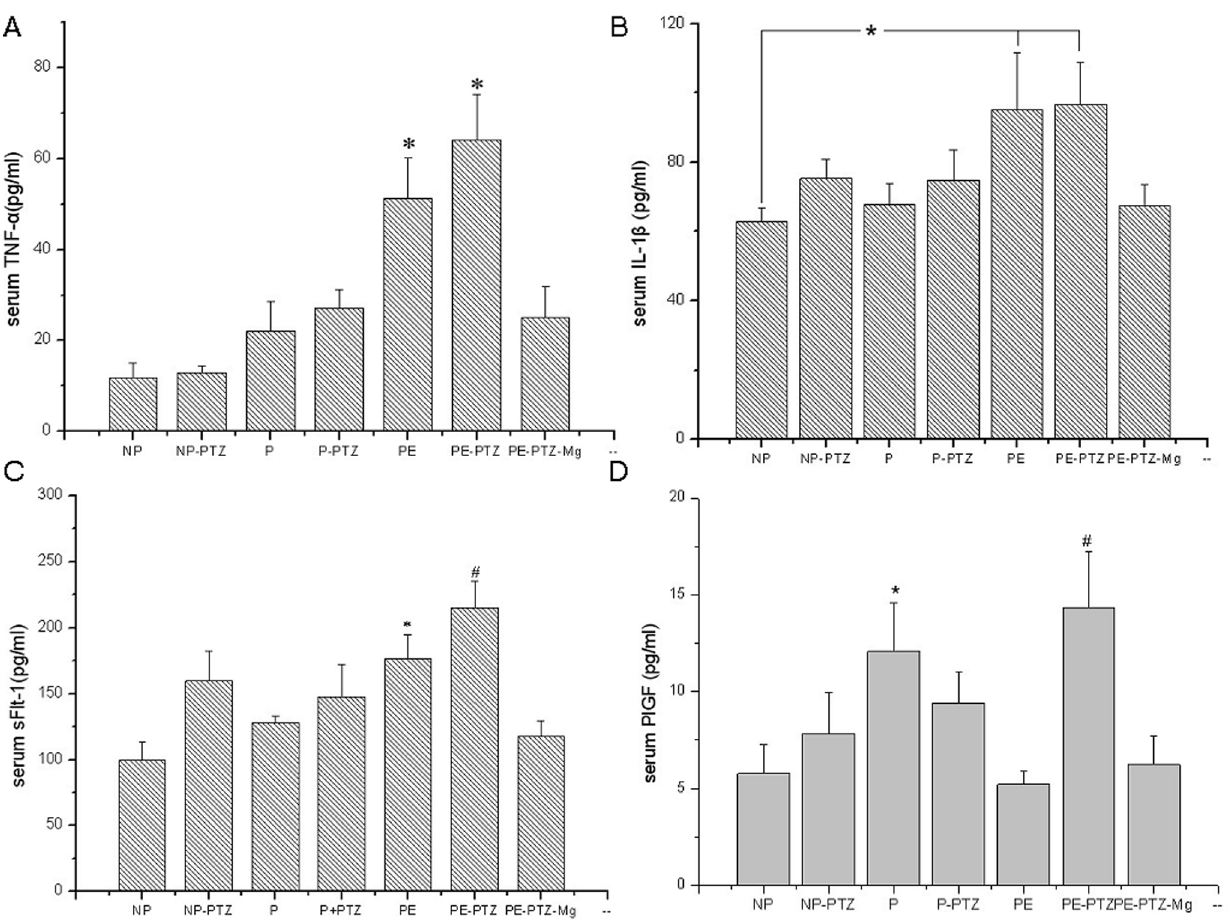
Figure 4. Inflammatory cytokines and preeclampsia biomarkers in different groups on GD 19. A * P , 0.05, PE-PTZ and PE groups compared with NP, NP-PTZ, P, P-PTZ and PE-PTZ-Mg groups. Serum levels of TNF- a significantly increased in the PE-PTZ and PE groups, and decreased in the MgSO 4 -treated group. B * P , 0.05, PE-PTZ and PE group compared to NP group. Serum levels of IL- b were higher in PE-PTZ and PE group. C * P , 0.05, PE groups compared with NP and PE-PTZ-Mg groups. # P , 0.05, PE-PTZ groups compared with NP, NP-PTZ, P, P-PTZ and PE-PTZ- Mg groups. Serum sFlt-1 increased in the PE-PTZ and PE groups. D * P , 0.05, P groups compared with NP, NP-PTZ, PE and PE-PTZ-Mg groups. # P , 0.05, PE-PTZ groups compared with NP, PE and PE-PTZ-Mg groups. Serum PlGF decreased in the PE group compared with the P group, but increased in the PE-PTZ group. (analysis of variance). doi:10.1371/journal.pone.0089333.g004 (i.p.) injection to induce a seizure state that mimics human Confirmation of Pregnancy eclampsia. In subsequent experiments, MgSO 4 (270 mg/kg body Adult female rats were housed with fertile males for one night, weight, i.p.) was given 20 minutes before PTZ injection to observe and then vaginal smears were taken and examined by microscopy the treatment effect on this animal model. the following morning. If sperm were found in the vaginal smear,